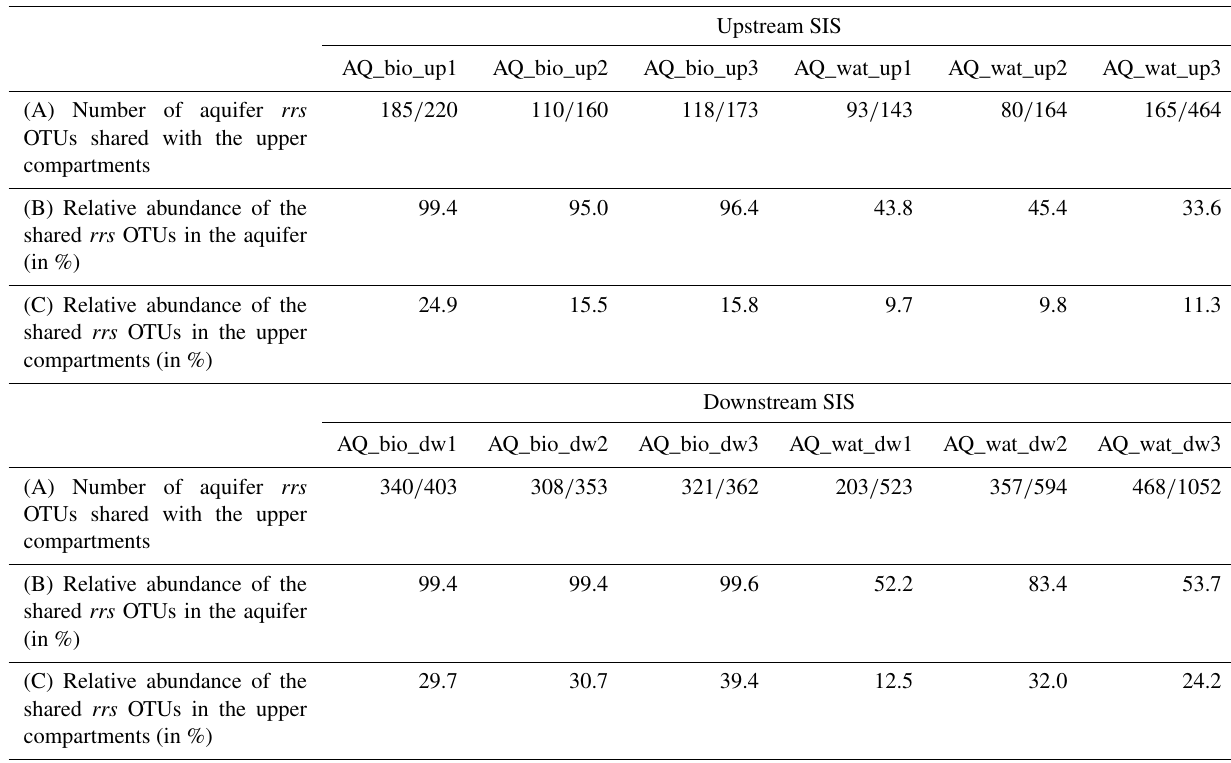
Table 2. Aquifer 16S rRNA gene ( rrs ) OTUs detected in the upper compartments of the investigated watershed and SIS ∗